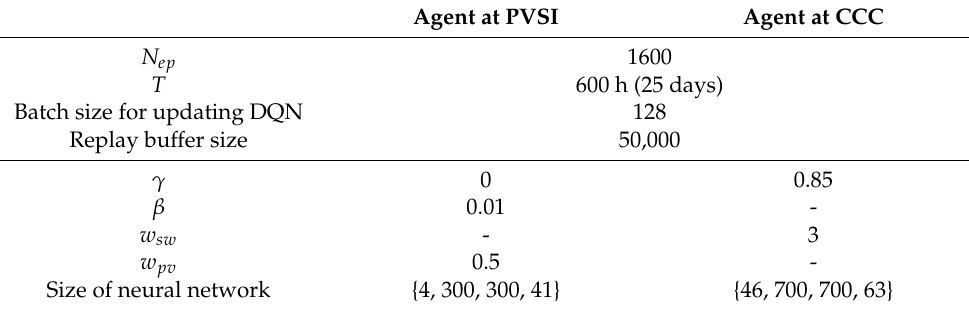
Table 2. DQN hyperparameters.